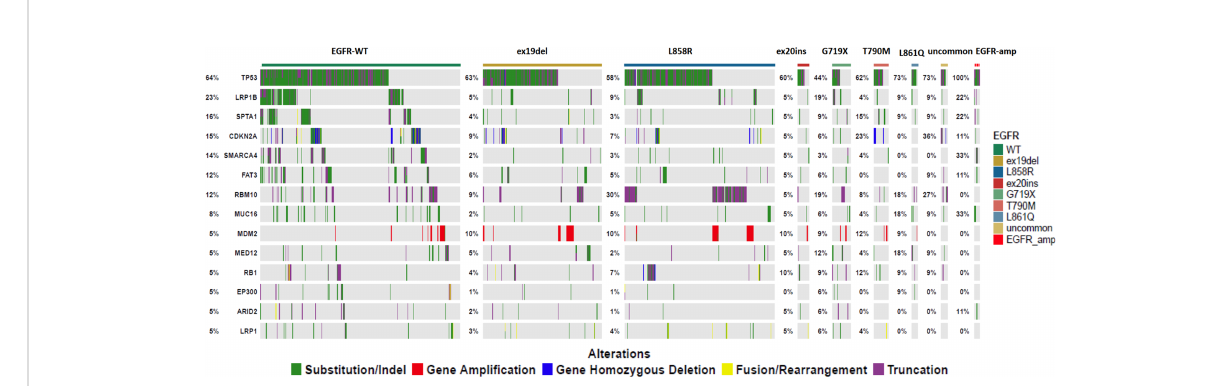
FIGURE 4 The co-mutation genetic alteration heatmap for different subtypes of EGFR mutations.